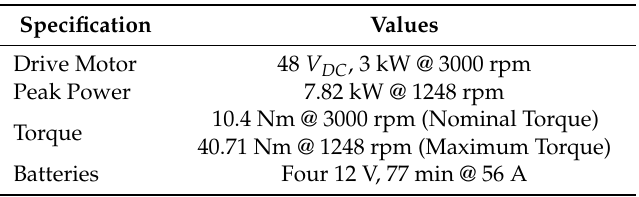
Table 4. Electric Motor HPEVS AC-20